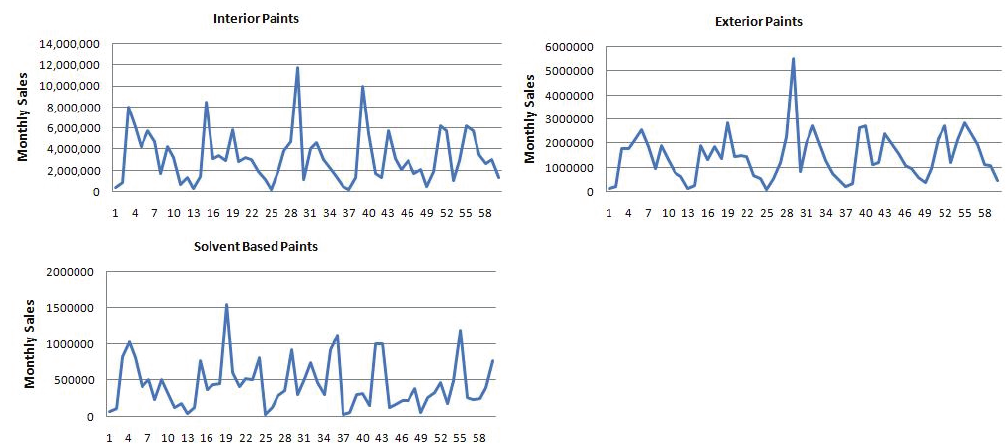
Fig. 1. Actual monthly product